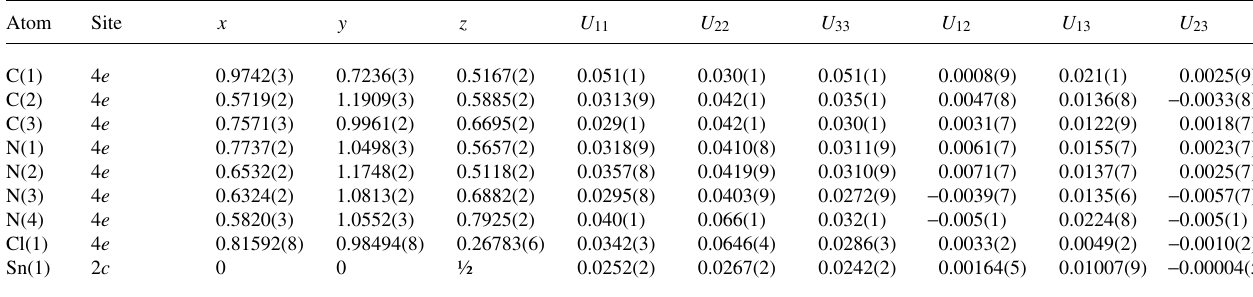
Table 3. Atomic coordinates and displacement parameters (in Å 2 ) .